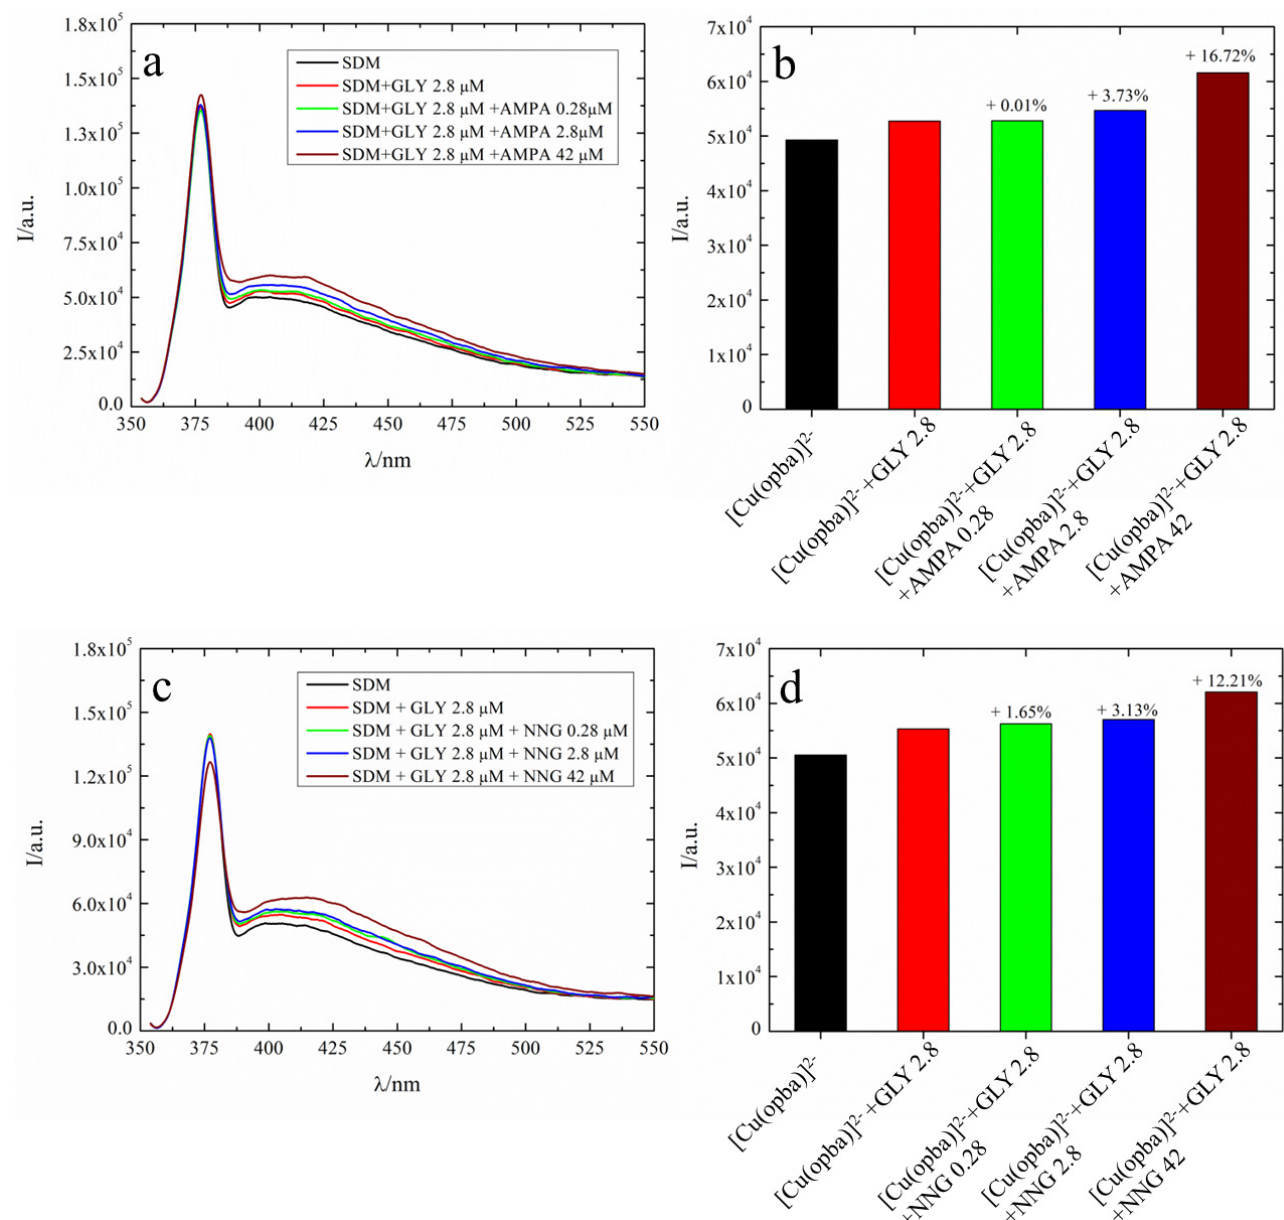
Figure 2. Emission spectra ( λ exc = 340 nm) of [Cu(opba)] 2 − (0.2 mM) plus GLY (2.8 µ M) and interfering effect of different concentrations (0.28 µ M, 2.8 µ M, and 42 µ M) of ( a , b ) AMPA and ( c , d ) NNG. RSD in all mixtures is below 1%.